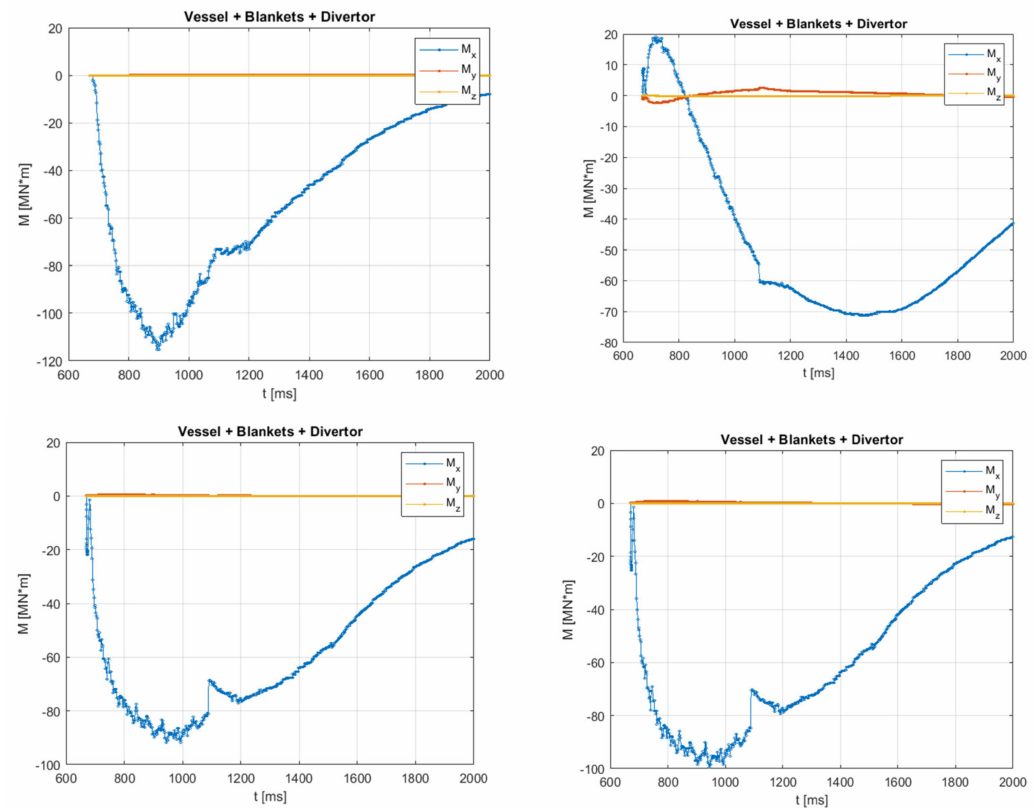
Figure 11. Comparison of all 4 models of bridges for the anti-symmetruic halo current component in terms of the dominant asymmetric EM load: overturning moment applied at the Vacuum Vessel with blanket and divertor due to interaction of asymmetric eddy currents with the toroidal field. Upper row: Models #1 and #2. Bottom row: Models #3 and